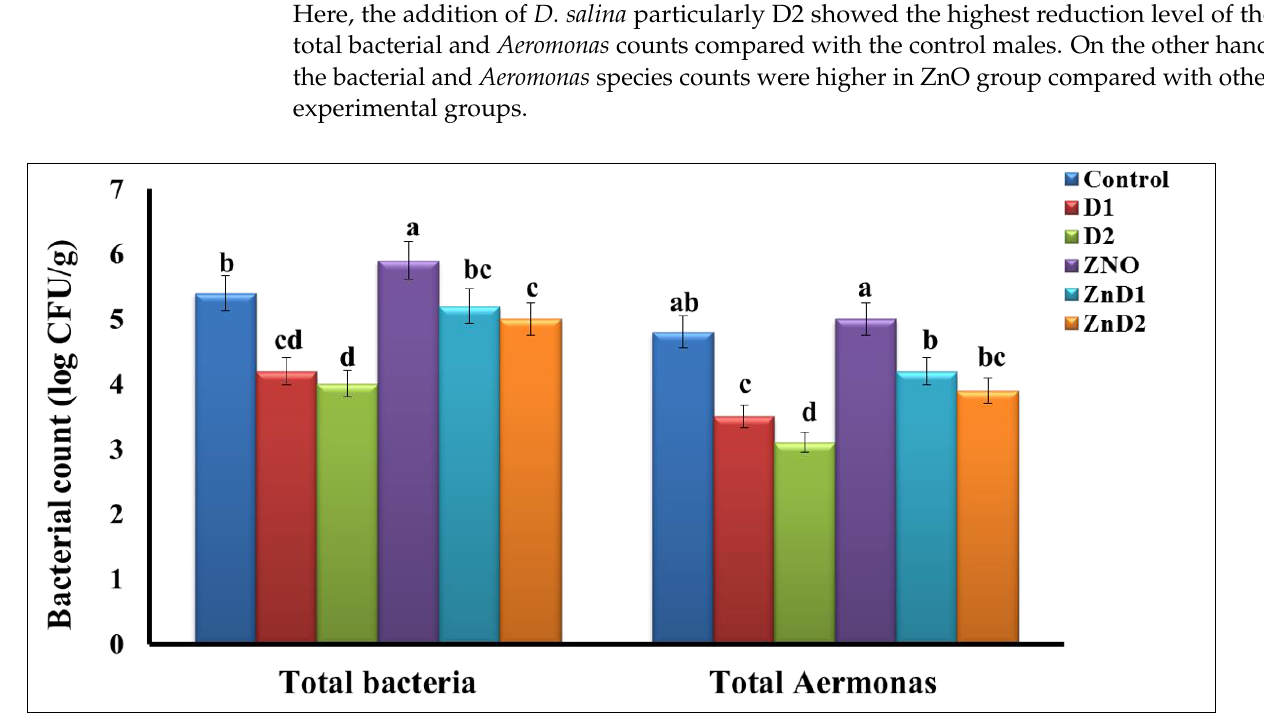
Figure 3. Total bacterial and Aeromonas count in the fishes’ intestines. Values among groups are not sharing a common superscript letter (a, b, c, d) differ significantly at p <